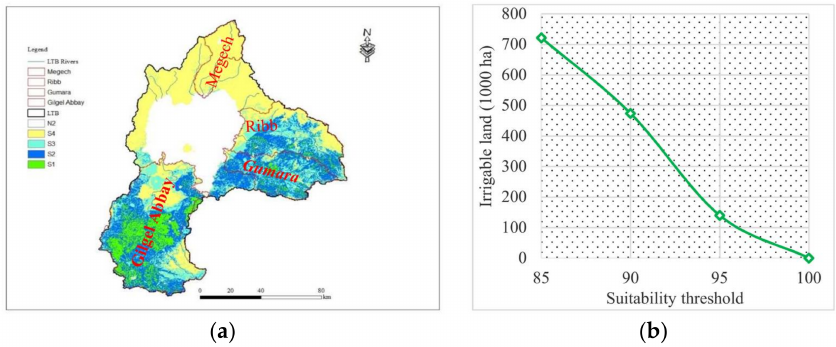
Figure 12. Irrigable land from rainwater harvest ( a ) 85% threshold; and ( b ) various thresholds.